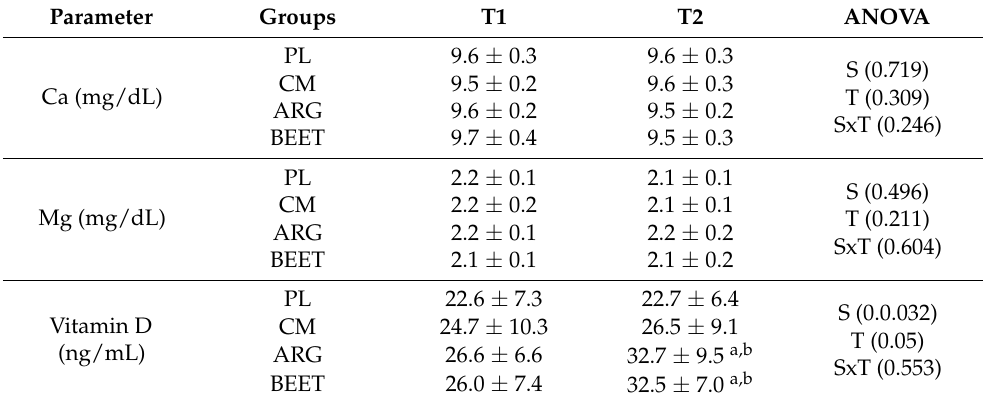
Table 4. Effects of supplementation with L-citrulline or L-arginine or nitrate-rich beetroot extracts on the calcium, magnesium and vitamin D plasma